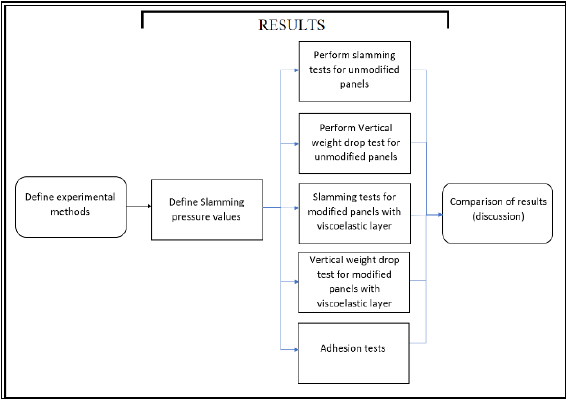
Figure 1. Organization of the research presented.